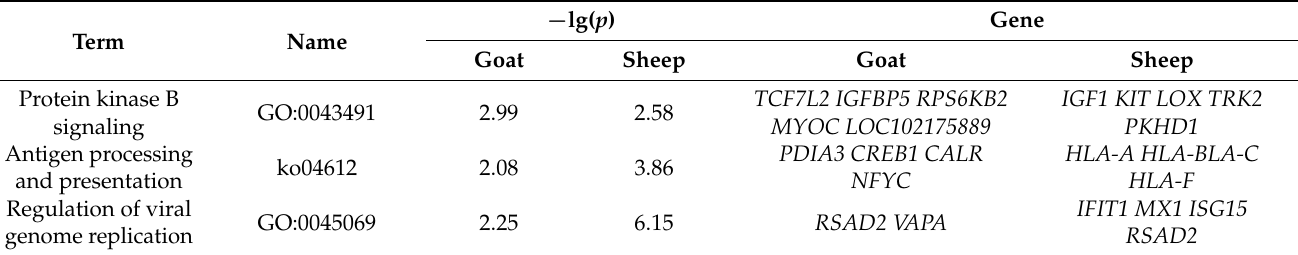
Table 3. Terms shared by differentially expressed genes of sheep and